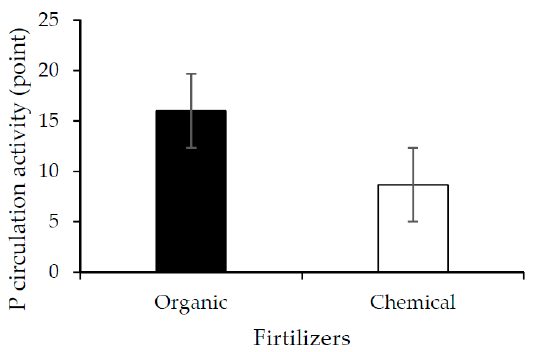
Figure 2. P circulation activity in organically and chemically fertilized soils.